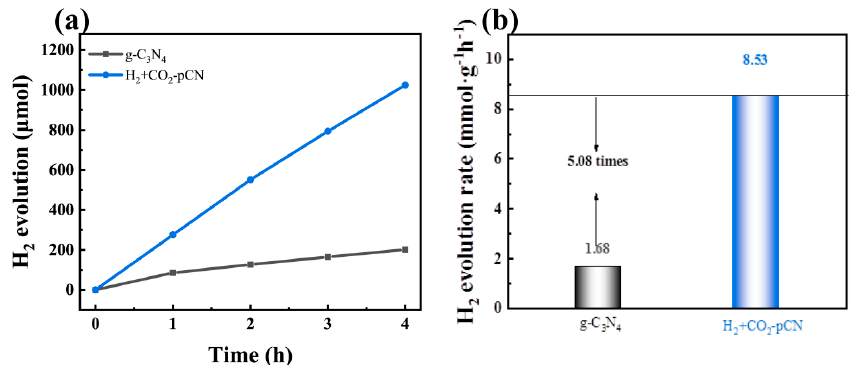
Figure 7. ( a ) Time course of H 2 evolution and ( b ) rates of the photocatalytic H 2 evolution over 5 wt.% Pt-loaded g-C 3 N 4 before and after H 2 +CO 2 plasma treatment in 10 vol% TEOA solution under visible-light irradiation ( λ ≥ 380 nm) (30 mg of the catalyst used in each experiment).